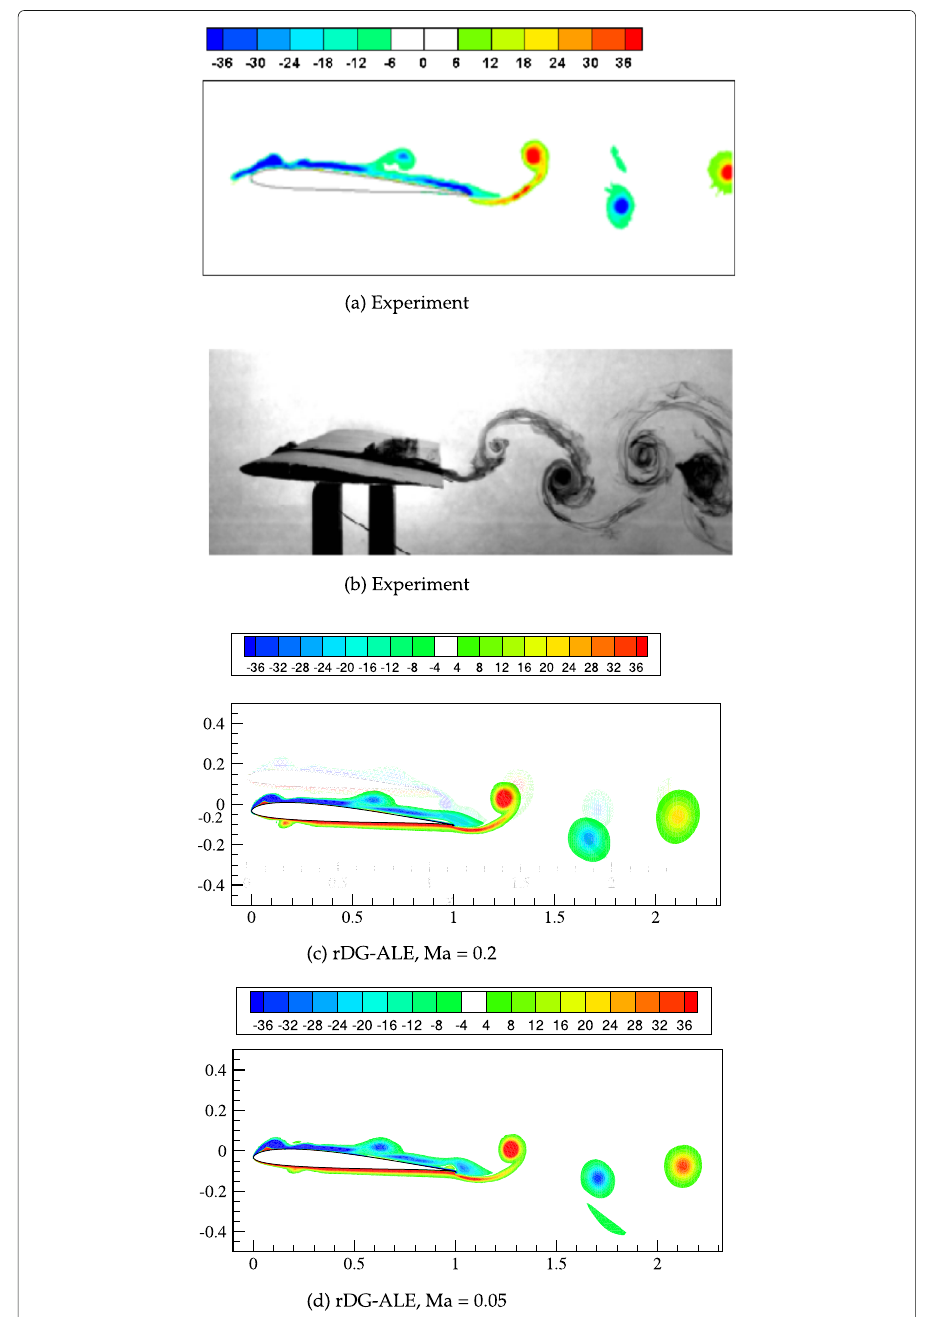
Fig. 20 Comparison of normalized vorticities with experiment at t 3 4 T for the plunging SD7003